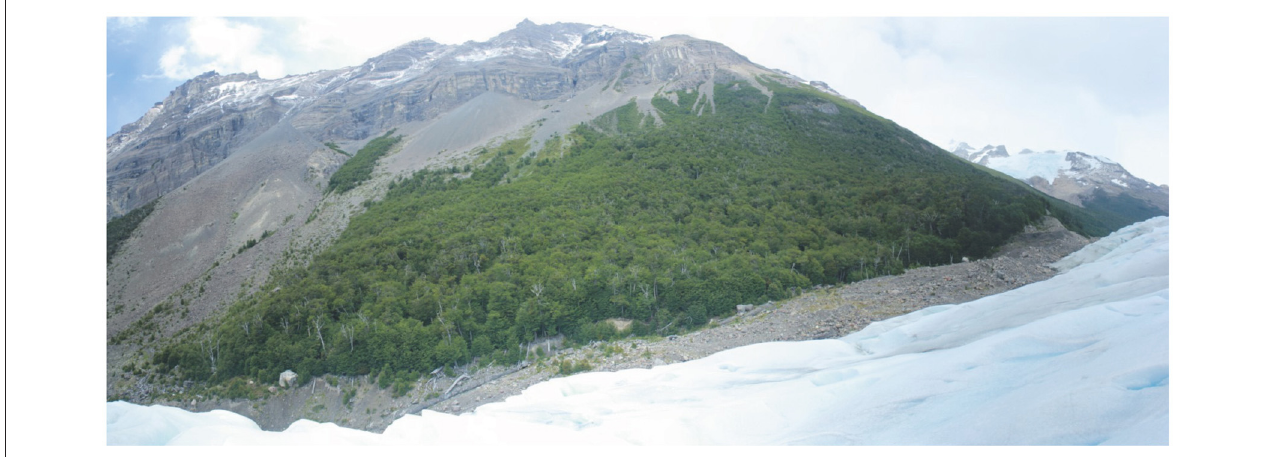
FIGURE 2 | Panoramic overview on the location of the sampled forest site on the Perito Moreno Glacier lateral moraine. Picture taken by B.L. Saß.